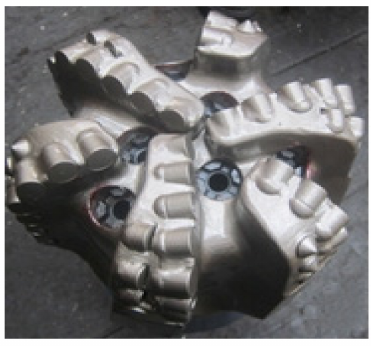
Figure 3. Composite impactor.